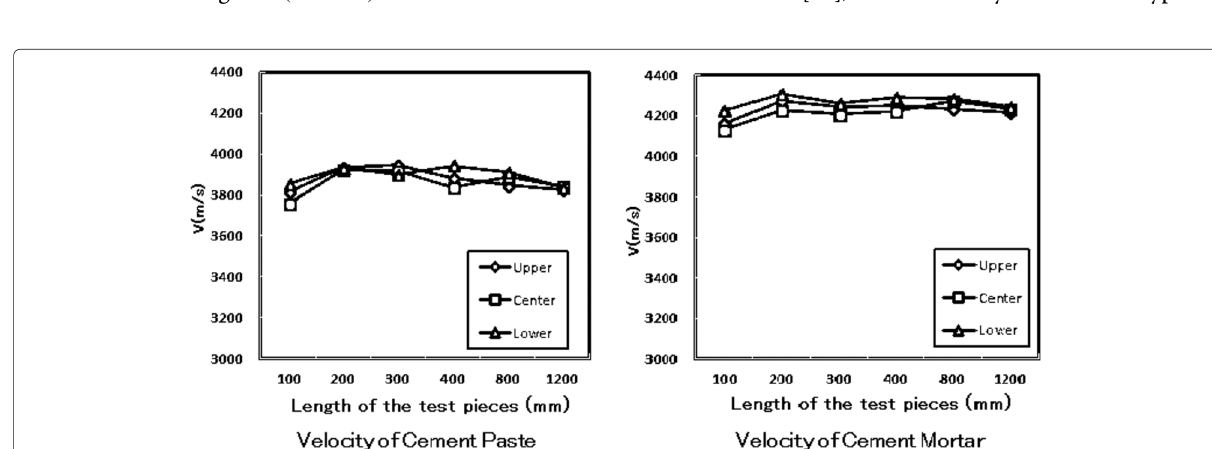
Fig. 3 Normal test pieces (age of 4